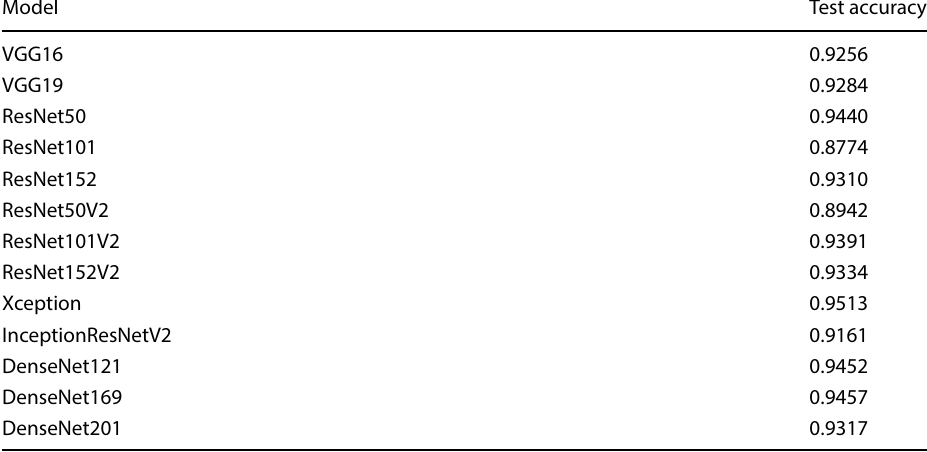
Table 5 Accuracy of various transfer models on 4 classes: normal, COVID, viral pneumonia, lung